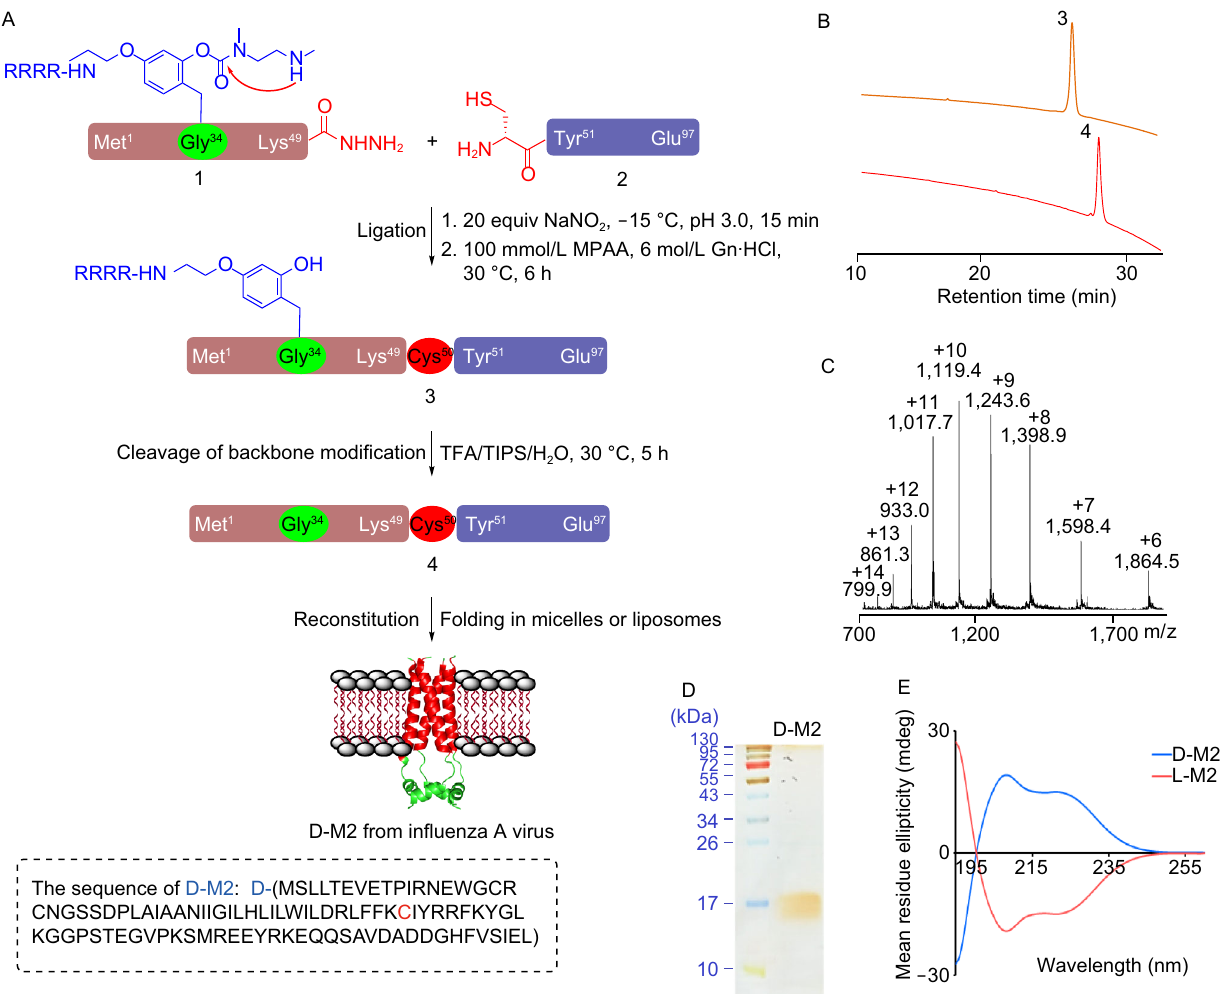
Figure 1. Peptide hydrazide-based chemical synthesis of D-M2 protein using the RBM strategy and protein characteriza- tions . (A) General synthetic route; (B) HPLC traces of puri fi ed RBM-tagged D-M2 and native D-M2; (C) ESI-MS of D-M2; (D) SDS- PAGE and silver staining analysis of D-M2; (E) Circular dichroism spectra of the folded L-M2 and D-M2. ∼ 5 μ mol/L of L-M2, D-M2